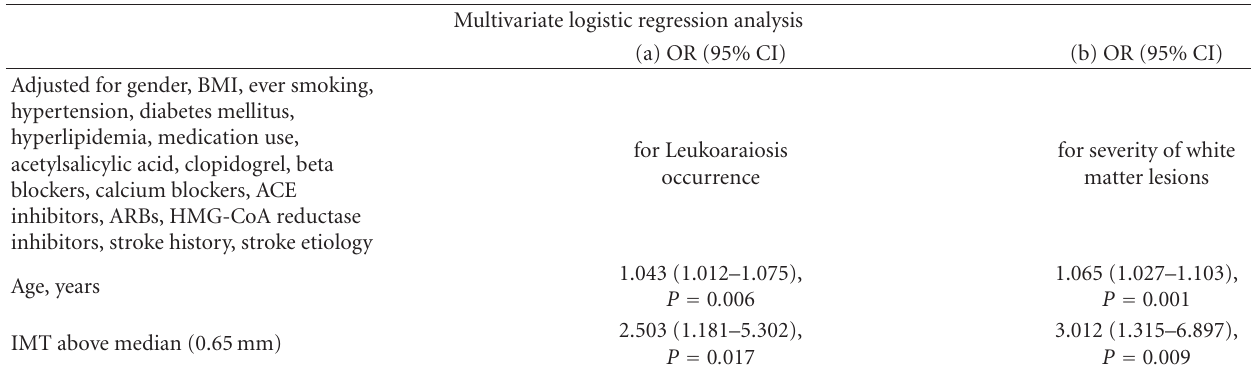
Table 2: (a) OR (95% CI) for incidence of leukoaraiosis. (b) OR (95% CI) for severity of white-matter lesions. Multivariate logistic regression analysis